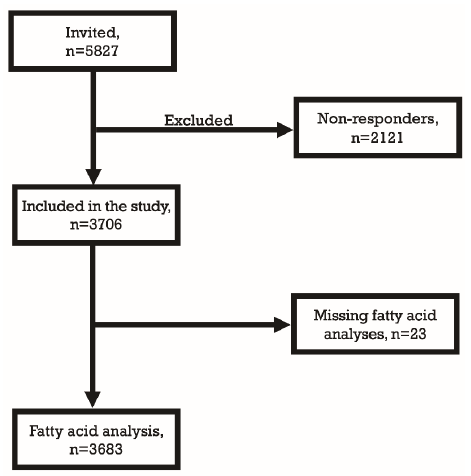
Figure 1. Flowchart for inclusion of study participants.